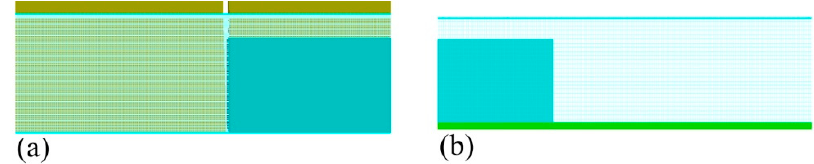
Figure 3b. Energies 2020 , 13 , x FOR PEER REVIEW